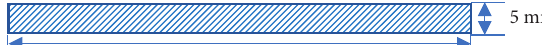
Figure 3: The schematic diagram of the narrow slit of the test box.